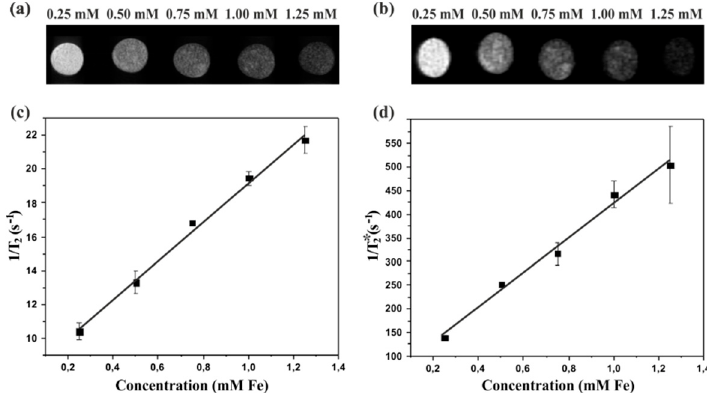
Figure 5. Phantom MRI studies of SPION-RGO. ( a ) T 2 -weighted and ( b ) T 2 *-weighted images of SPION-RGO at different concentrations. ( c ) R 2 and ( d ) R 2 * relaxation rates versus Fe concentration.